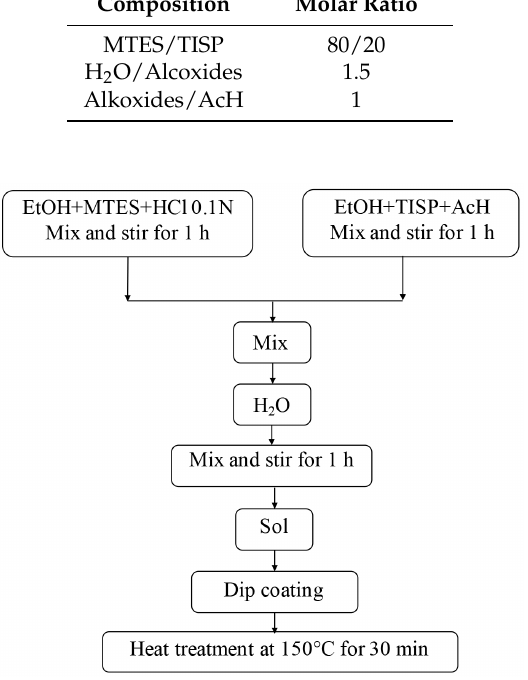
Figure 7. Flow chart of the preparation process of SiO 2 -TiO 2 thin films.